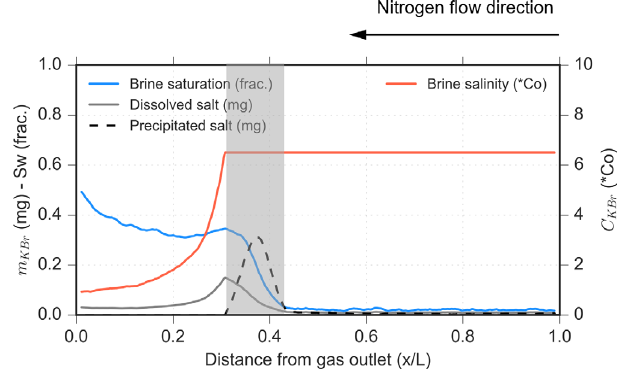
Fig. 11. Salt repartition in the different phases during the dry- out with capillary contact (t = 150 min). The grey area shows where the conditions for salt precipitation are met. The mass of salt is given for a pixel volume of 6.67 (cid:1) 10 (cid:3)